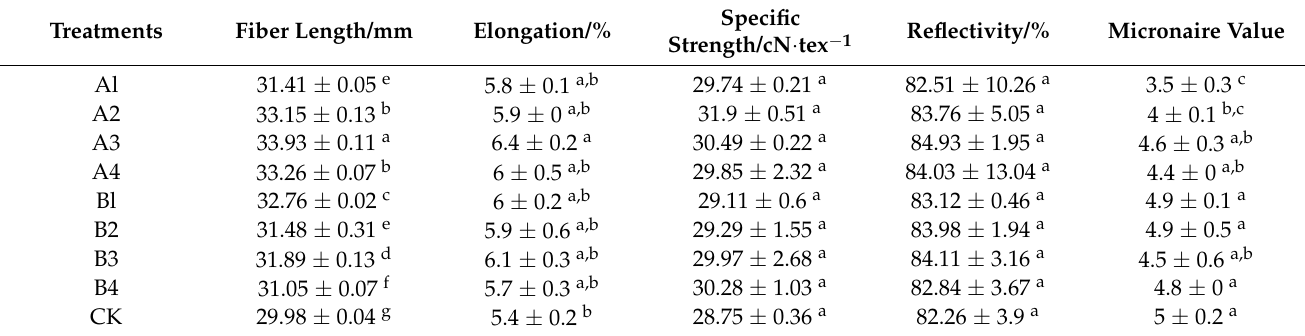
Table 5. Cotton fiber quality traits in different